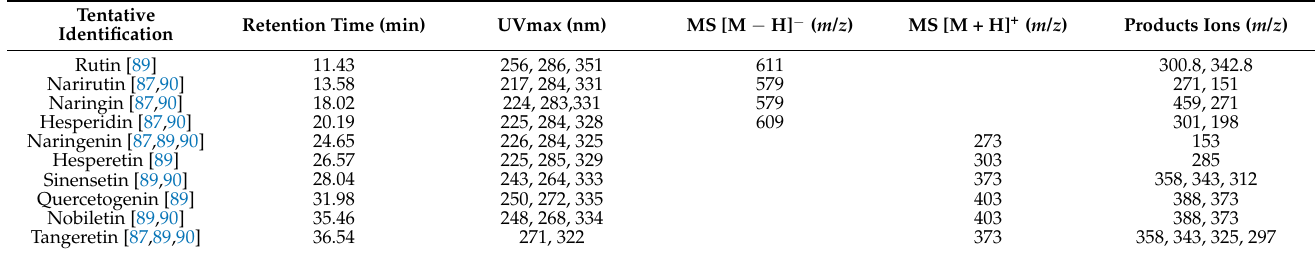
Table 3. Spectral data of flavonoids in orange peel